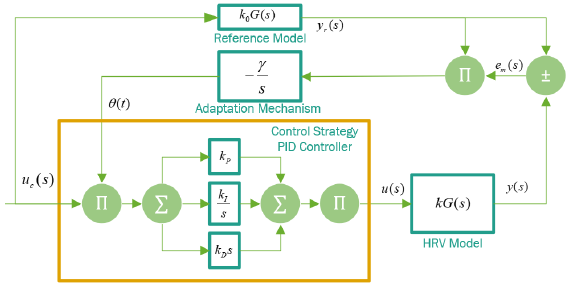
Figure 8. MRAC block